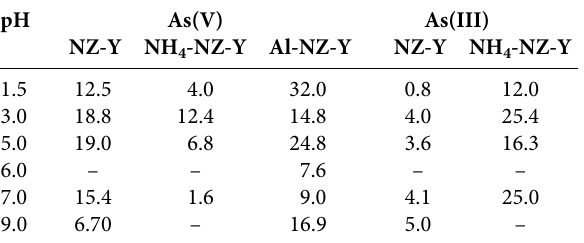
Table 2. The removal percentage of arsenic (III, V) with natural and modified zeolites as a function of pH (C Aso = 100 mg/ L). pH As(V) As(III)